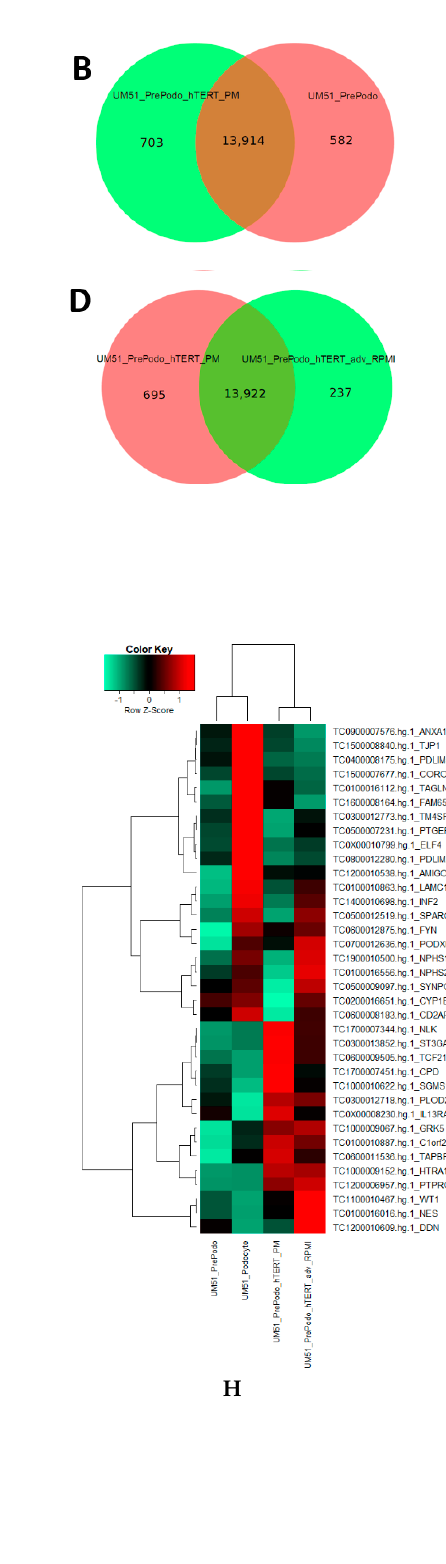
Figure 4. Comparative transcriptome and gene ontology analysis of urine-derived renal progenitor UM51 and derived immortalized UM51-PrePodo-hTERT. A hierarchical cluster dendrogram revealed distinct clusters of immortalized and wild type cells ( A ). Expressed genes (det-p < 0.05) in UdRPCs and podocytes compared in the Venn diagrams ( B – D ), showed distinct (582 in UM51-PrePodo; 703